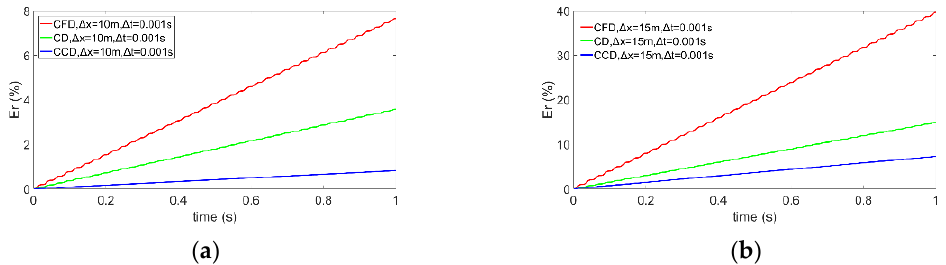
Figure 3. Relative errors of numerical simulation for different schemes and gird size: ( a ) Δx = 10 m, Δt = 0.001 s ; ( b ) Δx = 15 m, Δt = 0.001 s .